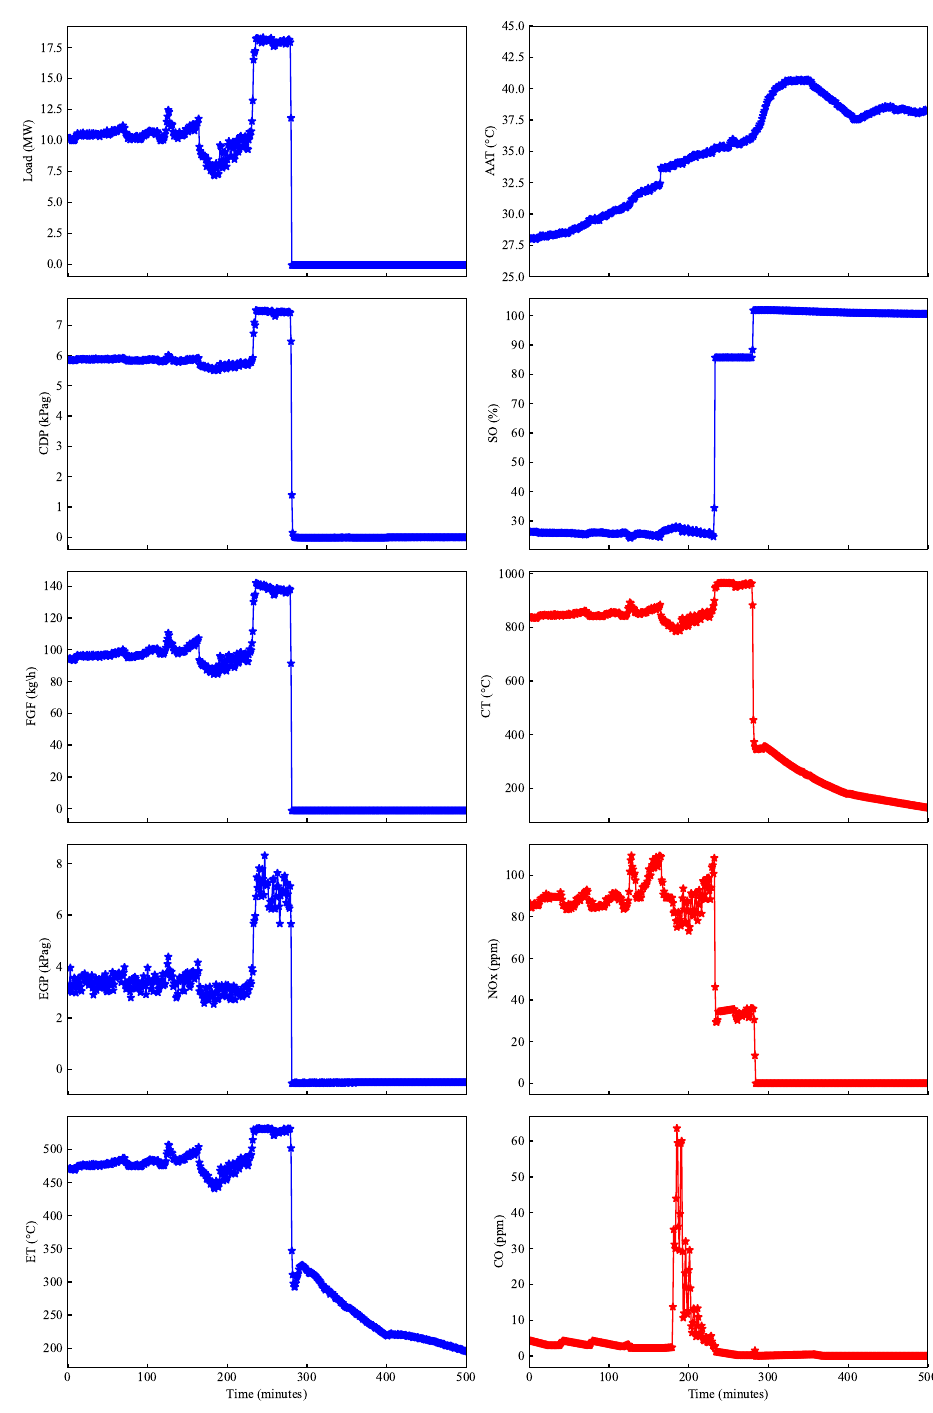
Figure 6. Trip signature from parameters of the DLE gas turbine. Further analysis exhibits a similar trend of CDP and FGF, where both parameters rise quickly due to the sudden load increase. Since the gas turbine is a single-shaft type with relatively constant speed, the increase in load demand is followed by an increase in the fuel flow or FGF, which raises the combustion temperature, CT. Thus, a large opening of the splitter, SO, is identified from 25% to 88% during load change; then, it increased to 100% or was fully open during the trip. The increase in CT affects the rise of CDP, where CDP is used to estimate the firing temperature reference. Other parameters, such as exhaust temperature (ET) and exhaust gas pressure (EGP), also have an identical pattern